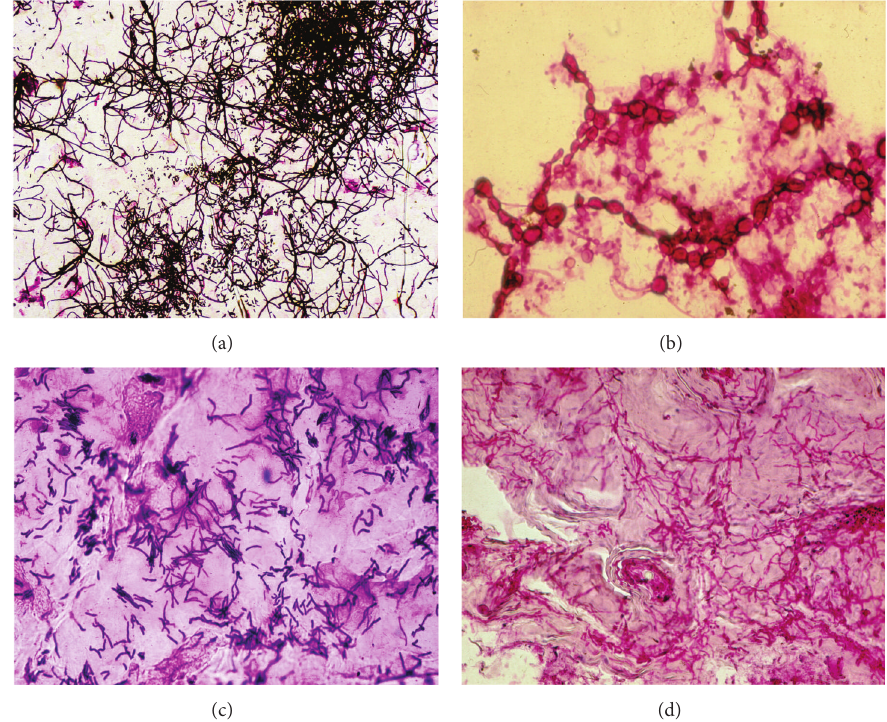
Figure 5: Fungal invasions. (a) Dermatophyte infection. (b) Candida sp. infection. (c) Malassezia sp. in pityriasis versicolor. (d) Tinea capitis.